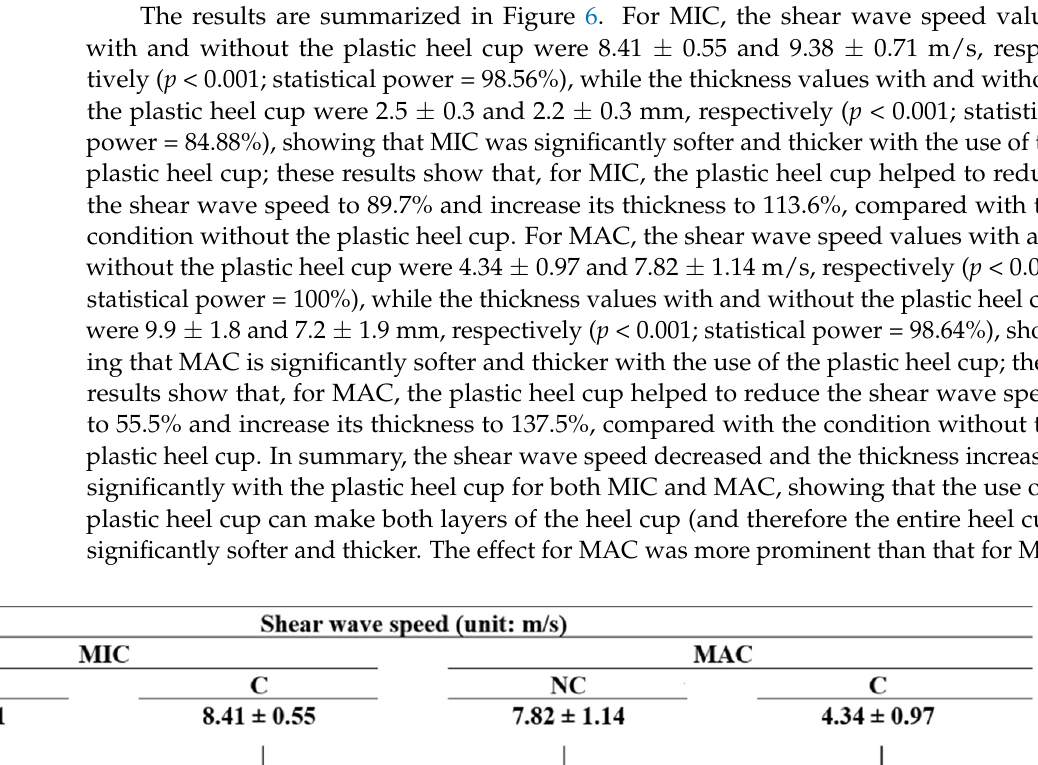
( b ) Figure 7. Illustration of an example of the color maps with ( a ) and without ( b ) a plastic heel cup of a symptomatic heel pad of a plantar fasciitis patient. It can be clearly observed that the heel pad (especially for the deep MAC) was significantly softer and thicker with a plastic heel cup. 4. Discussion The most important finding of the present study is that a plastic heel cup can effec- tively help to reduce the stiffness (in terms of the shear wave speed) and increase the thickness for both MIC and MAC of the heel pad of the affected side in plantar fasciitis patients during static standing, evaluated by ultrasound SWE. This finding suggests that